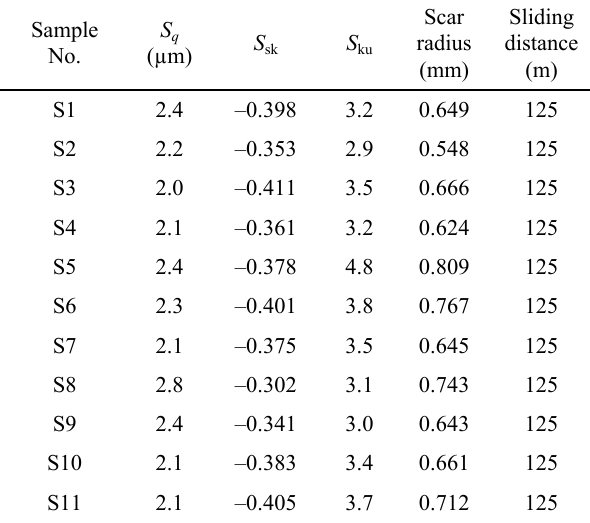
Fig. 8 Optical micrographs of six pin surfaces (S1 − S6) after short duration tests (scar radius is indicated with red color on each micrographs).